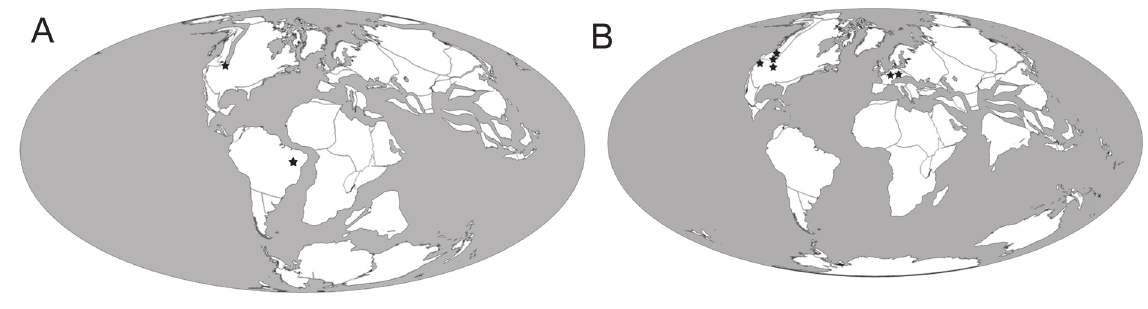
Figure 6 - First distribution patterns of Smilacaceae during Mesozoic and Cenozoic. A. In the Cretaceous, limited to Brazil and USA. B. In the Paleogene the records are limited, up to now to the Northern Hemisphere (USA and